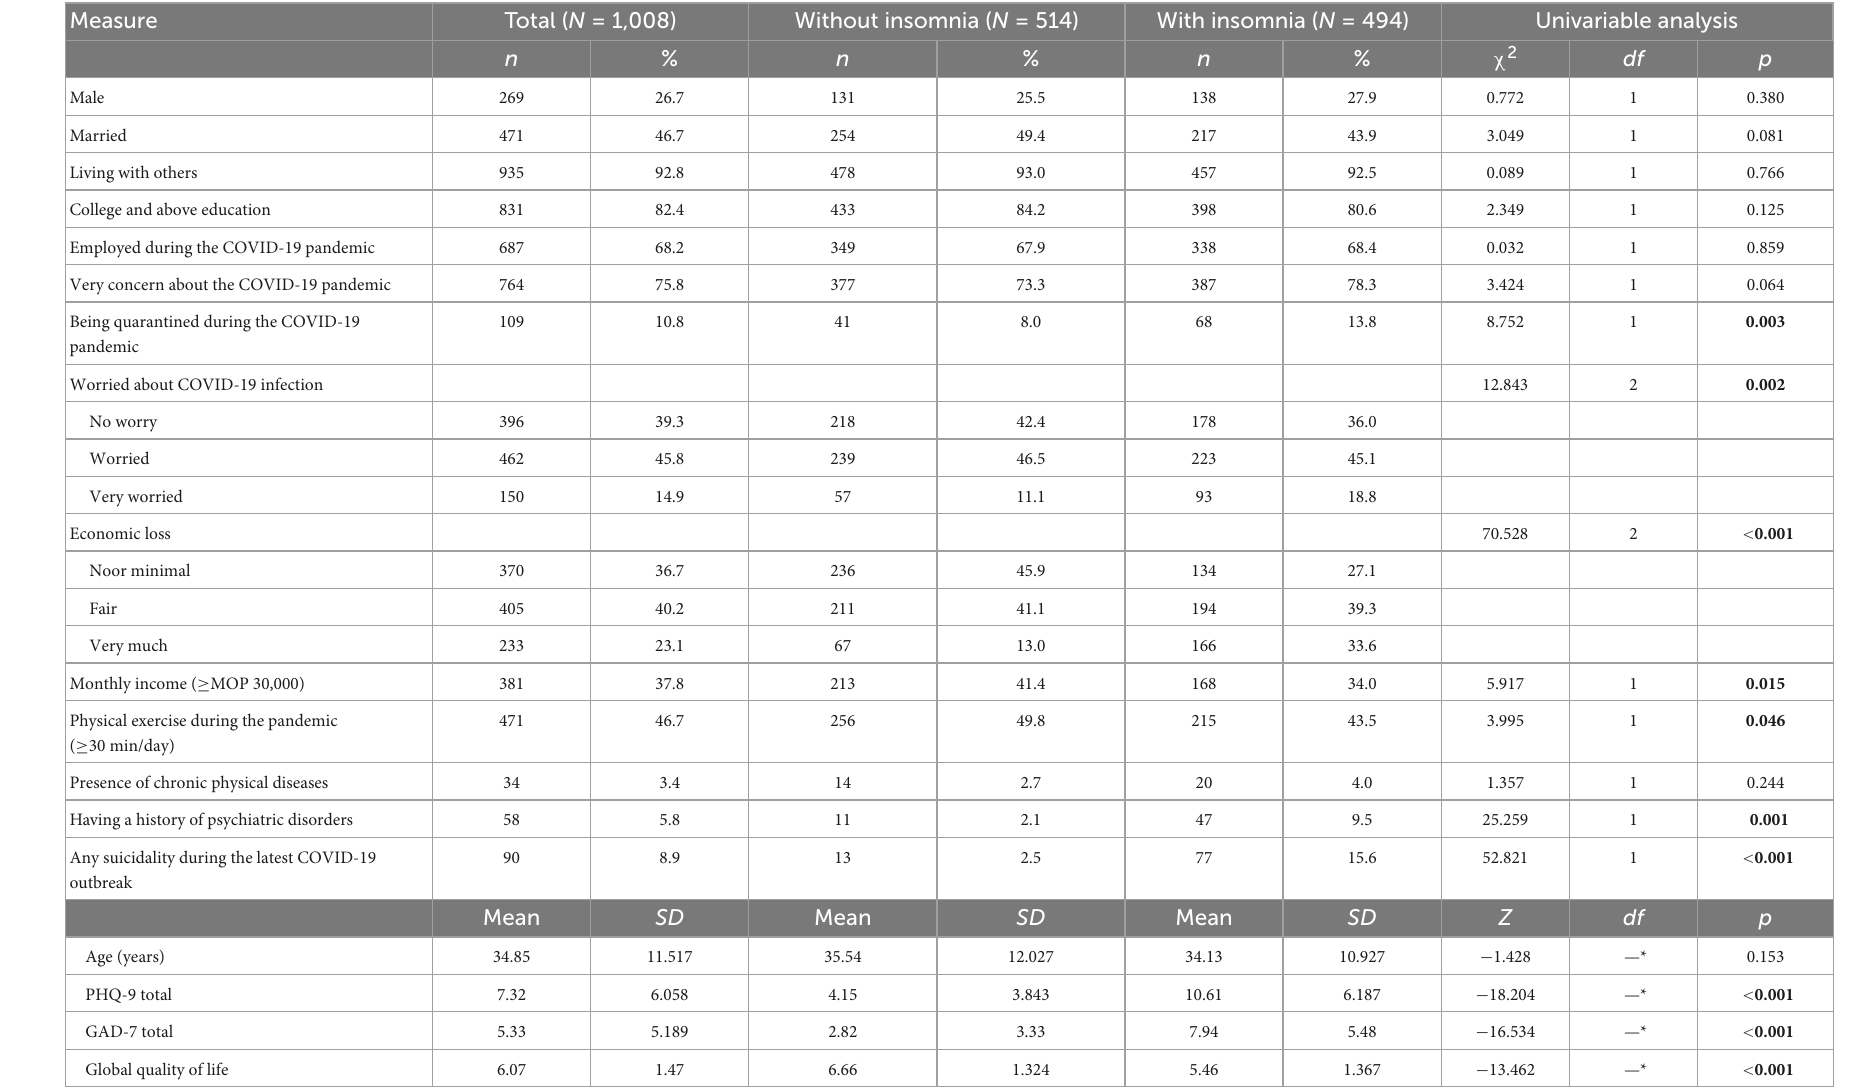
TABLE 1 Demographic characteristics of the study sample ( N =